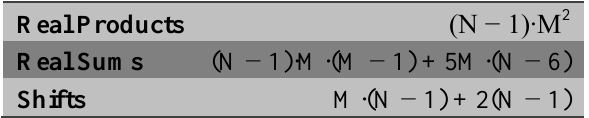
Table 3. Operations needed for range bin